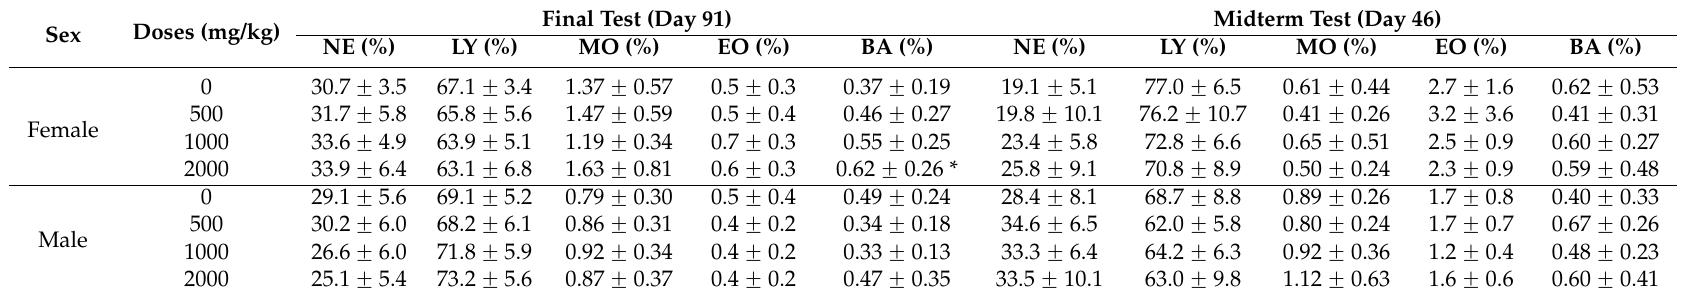
Table 7. Effect of GBP on WBC classification count (CBC) (x ˘ s, n =